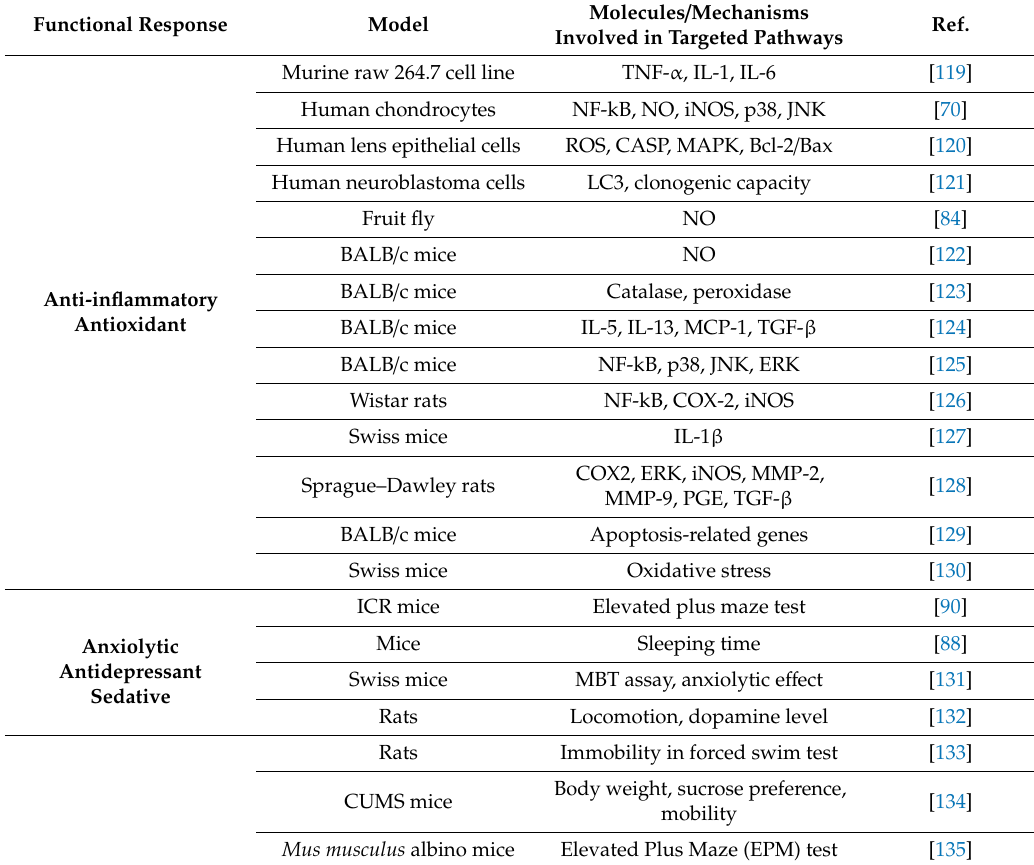
Table 5. Preclinical evidence of limonene biological